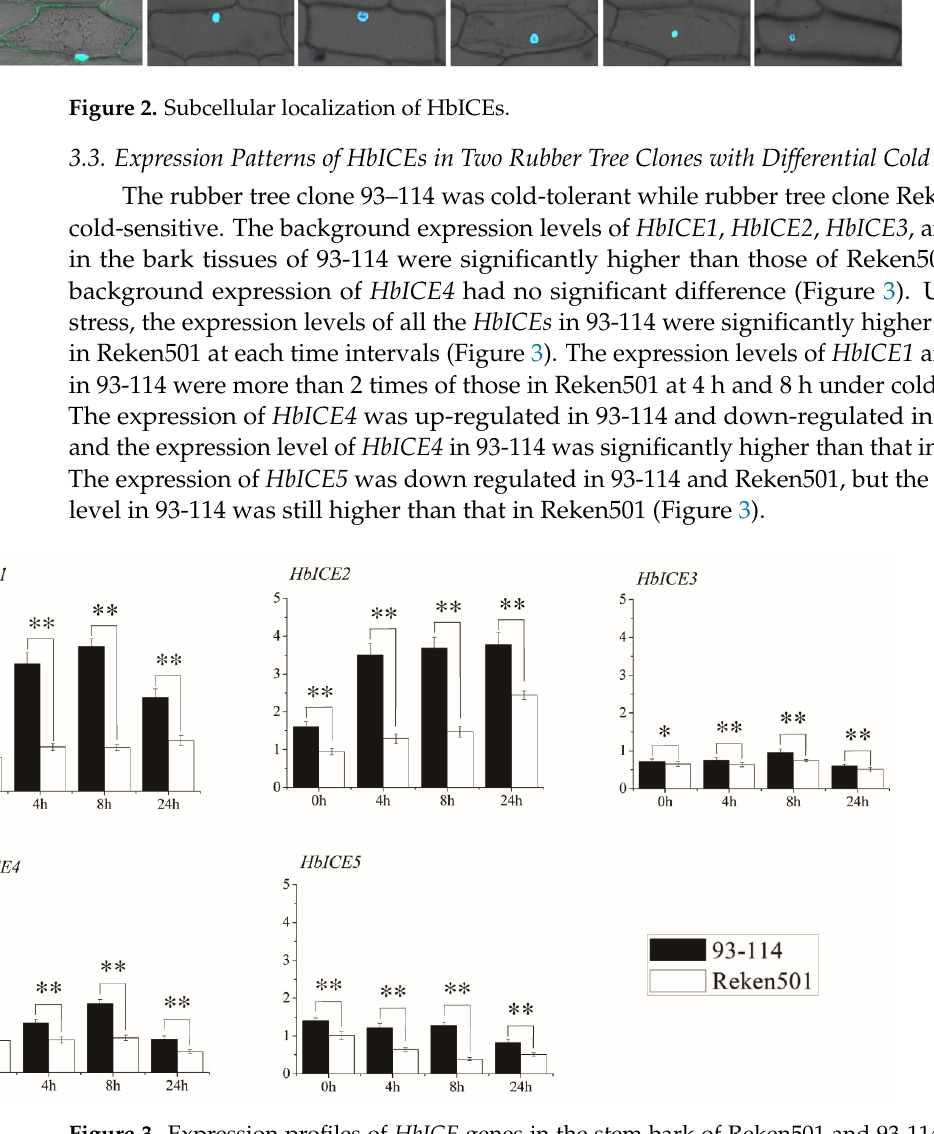
Figure 3. Expression profiles of HbICE genes in the stem bark of Reken501 and 93-114 upon cold stress. The asterisks (**) and (*) respectively represented very significant difference ( p < 0.01) and significant difference ( p < 0.05).